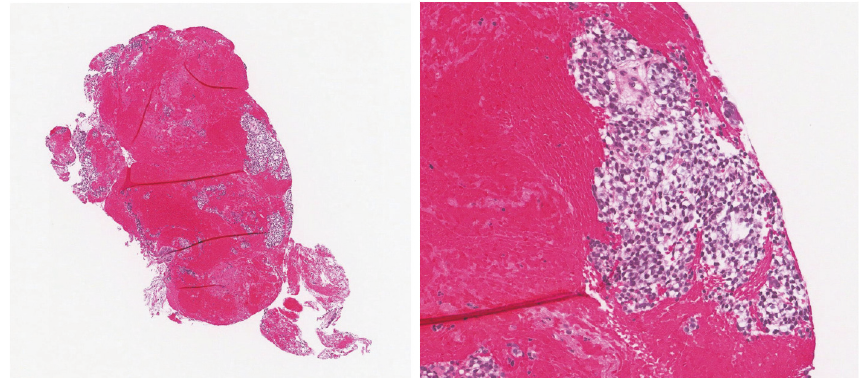
Figure 7: Representative low and high power images of bronchoscopic biopsies seventeen months later. The two lung nodules from the left lower lobe showed morphology consistent with metastatic